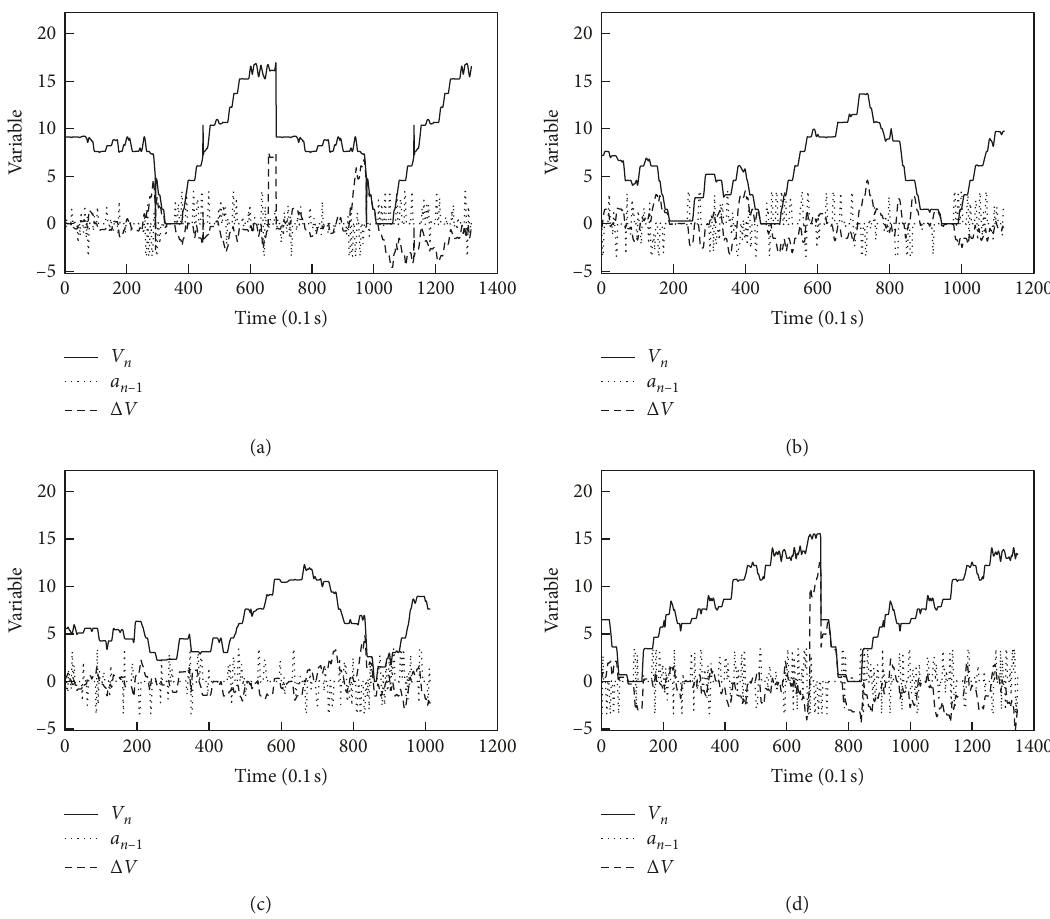
Figure 3: An example of time-varying correlations of speed of the lag vehicle with car-following spacing and acceleration rate of the lead vehicle. (a) Line 1, (b) line 2, (c) line 3, and (d) line